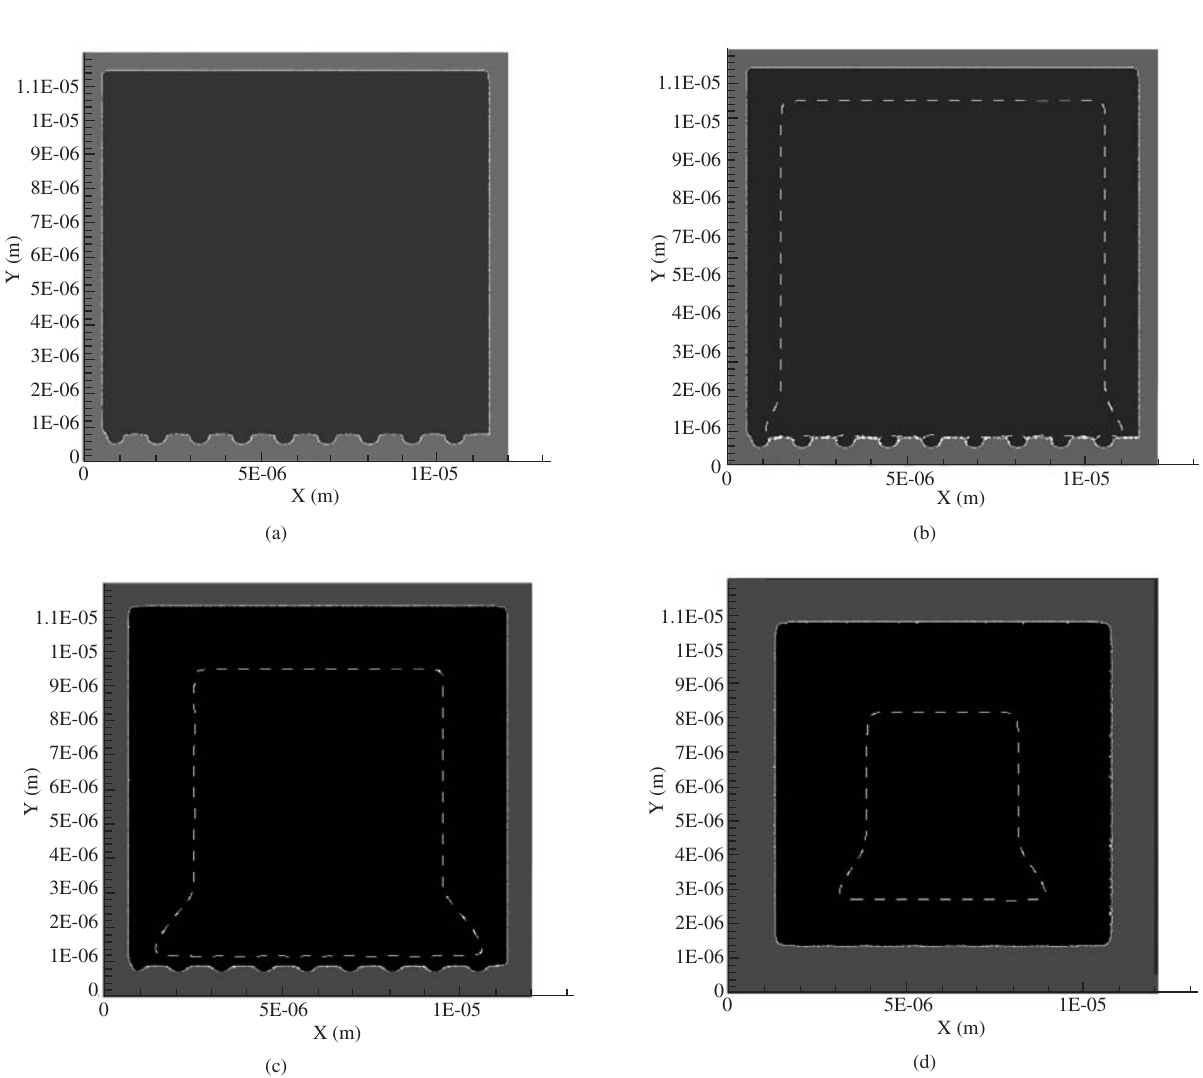
Figure 3. Development of the smooth interface from an initially disturbed region. Solidification time is a) t = 0; b) t = 6.9 x 10 -9 s; c) t = 9.5 x 10 -9 s; and d) t = 2.2 x 10 -8 s, and the melting temperature isotherm (Tm = 1728 K) is also